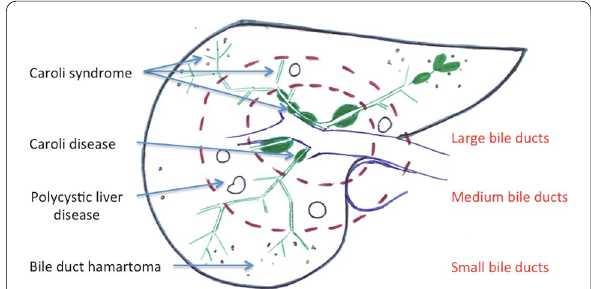
Fig. 2 Schematic figure (axial section of a liver) showing the different types of ductal plate malformation. The size of the affected ducts is closely correlated to the ductal development phase